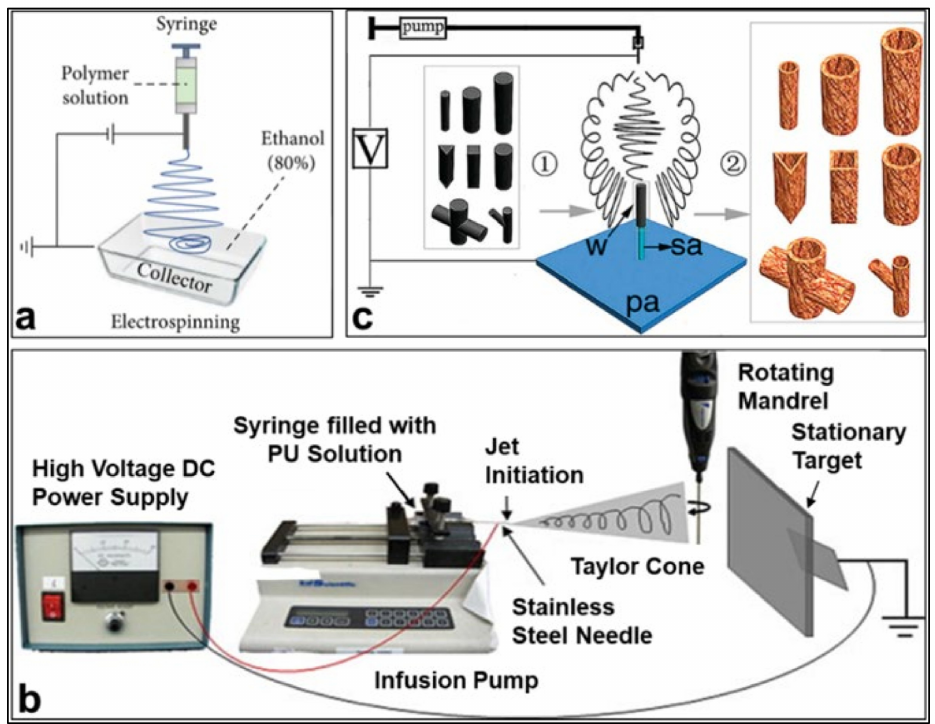
Figure 12. Comparison of devices for forming nanofibers with 3D structures by liquid-assisted collection and template-assisted collection. ( a ) Liquid collector [186]; ( b ) Rotary collector, Reprinted with permission from [233] copyright 2010, Elsevier. ( c ) 3D cylindrical collector, Reprinted with permission from [234], copyright 2008, American Chemical